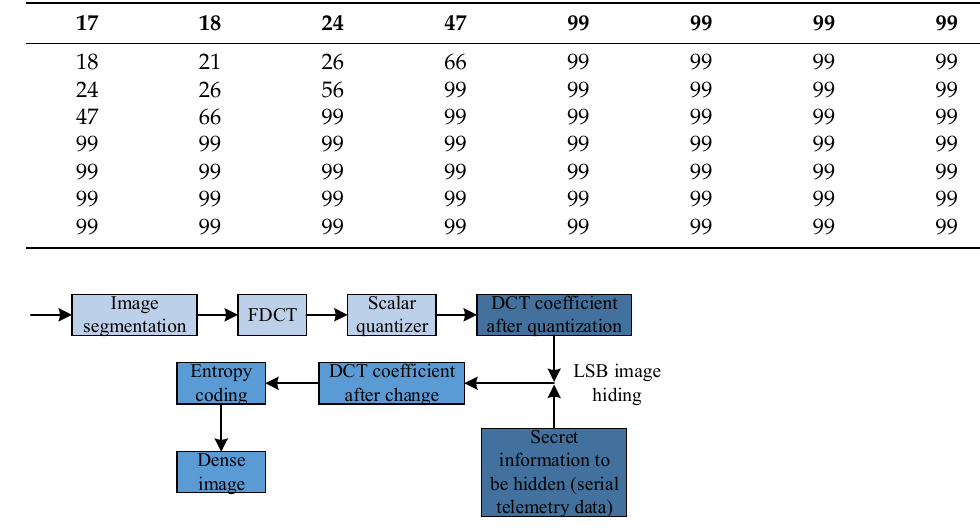
Table 10. Image coding hidden color-difference quantization.